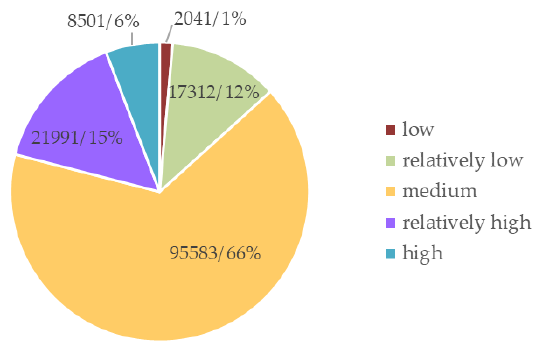
Figure 12. Pie chart of grade distribution of alarm messages.